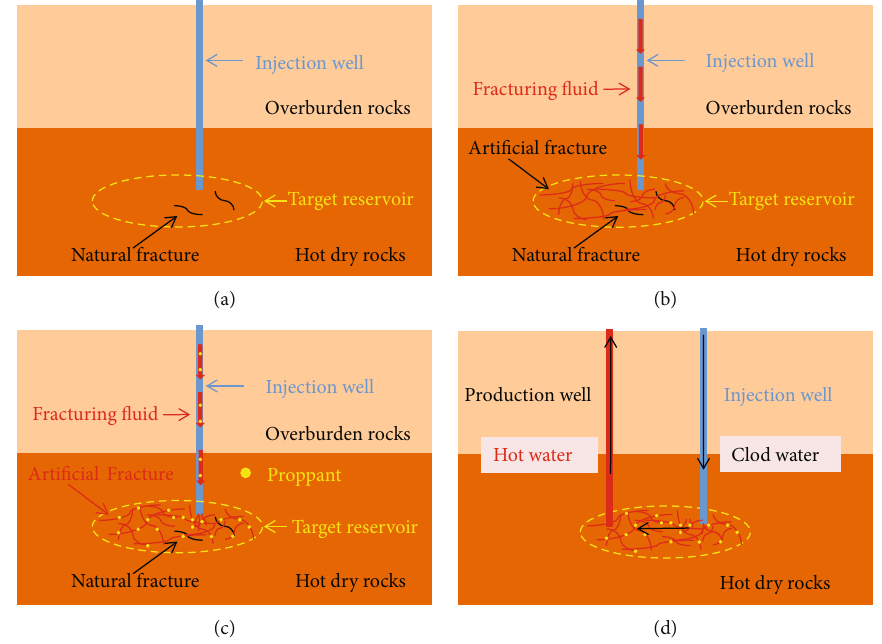
Figure 1: Schematic of EGS with arti fi cial fracture networks by hydraulic fracturing.